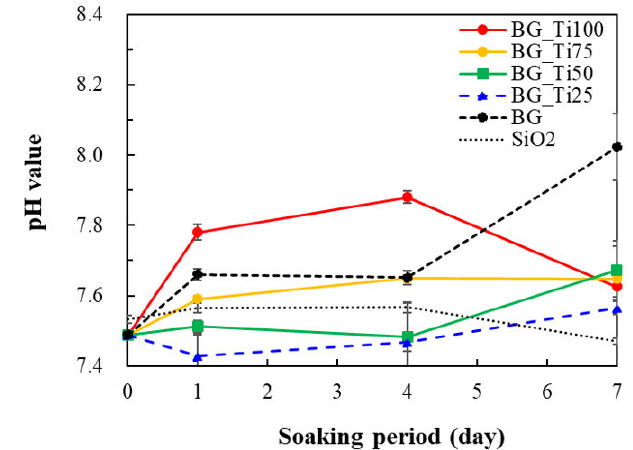
Figure 3. The pH value of SBF after the immersion of bioceramics composed of silica and titanium oxide with various concentrations of titanium oxide for 7